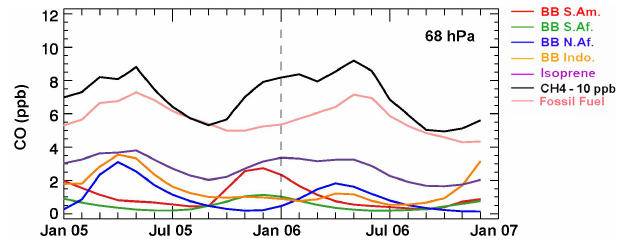
Fig. 14. Monthly mean of tagged CO tracers over the tropics (11 ◦ S to 11 ◦ N) from individual sources: biomass burning in South Amer- ica (red), southern Africa (green), northern Africa (blue) and In- donesia (orange): the biogenic source from isoprene oxidation (pur- ple), methane (black, adjusted by 10ppb) and the source from fossil fuel (pink) combustion for GEOS-4 at ∼